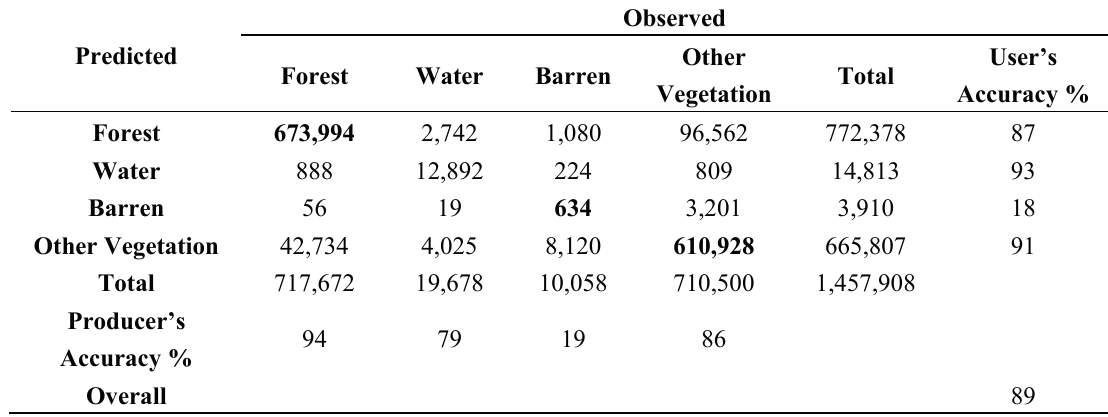
Table 2. Confusion matrix showing producer’s, user’s, and overall accuracies. Observed Predicted Forest Water Barren